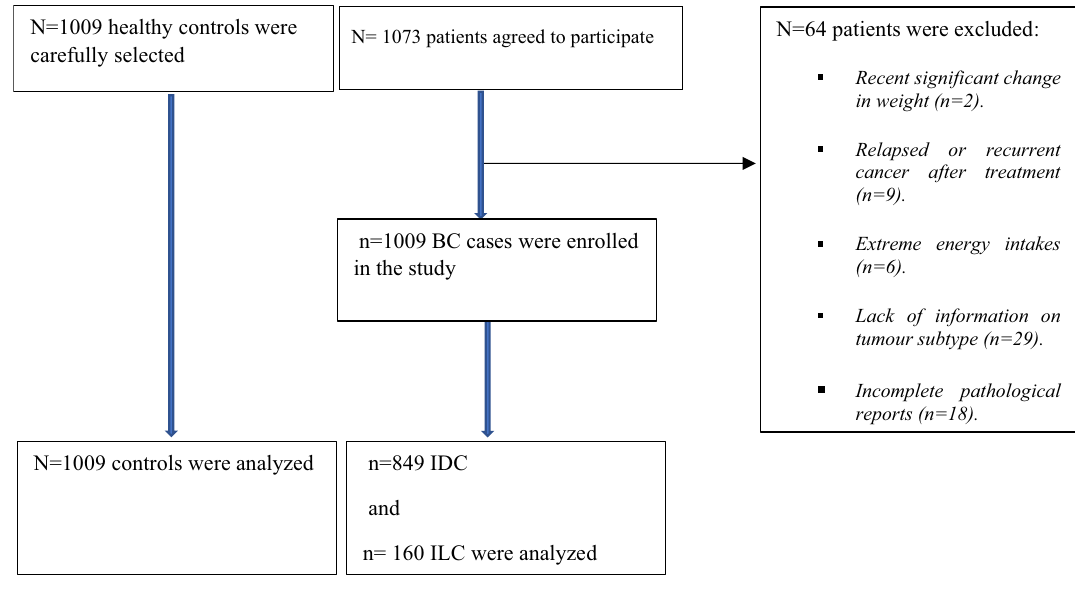
Figure 1. The study follow